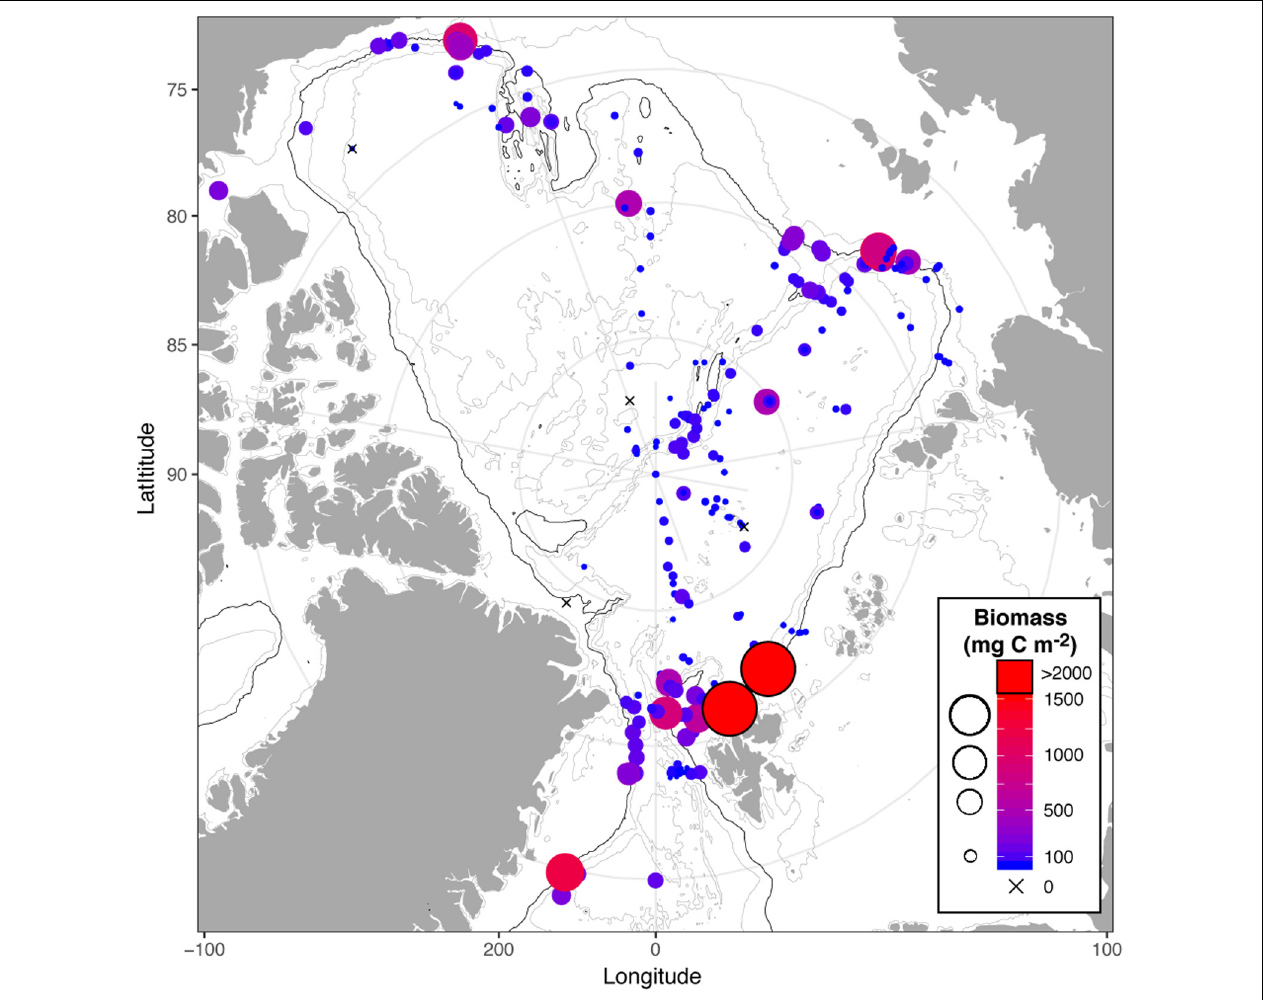
FIGURE 1 | Biomass of benthic macrofauna in the Arctic Ocean basins and adjacent areas (data compiled from Bluhm et al., 2015; Degen et al., 2018; Vedenin et al., 2018). Note biomass values for depths ≥ 500 m are included in the figure to show the decline from the upper slope to the central basins. The 1000 m isobaths is depicted as a black